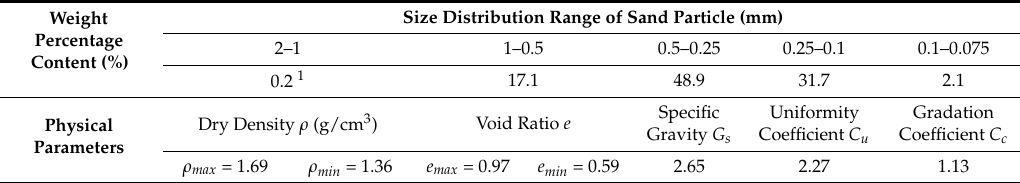
Table 1. The basic behaviors of the used